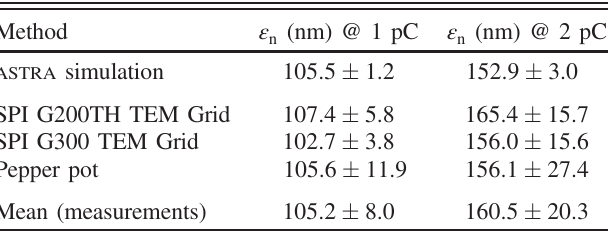
TABLE IV. Summary of the grid-based measurements, used to verify the FCNN results. The measurements are compared to the ASTRA simulation result.